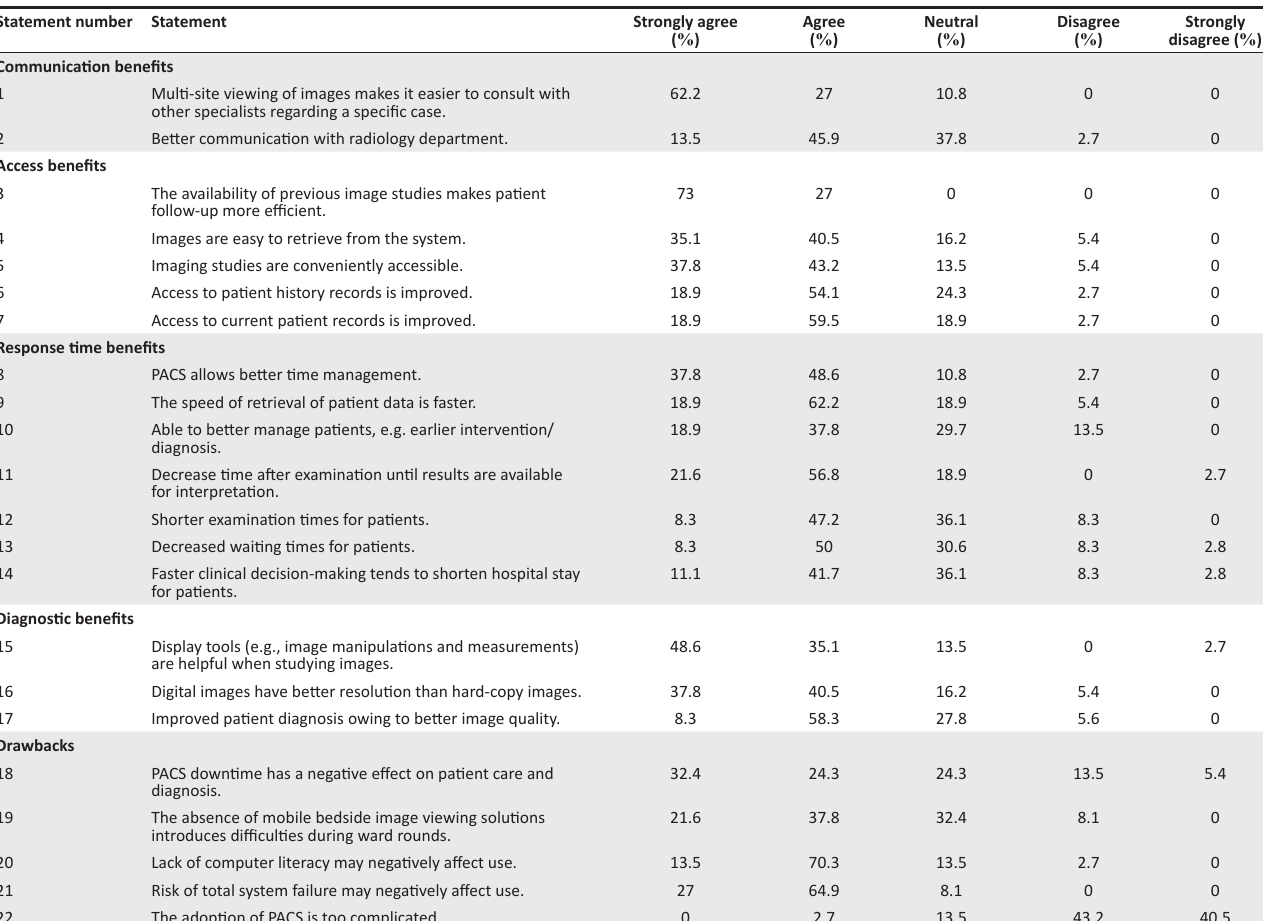
FIGURE 3: Participant comfort levels in the use of TABLE 1: Survey results.